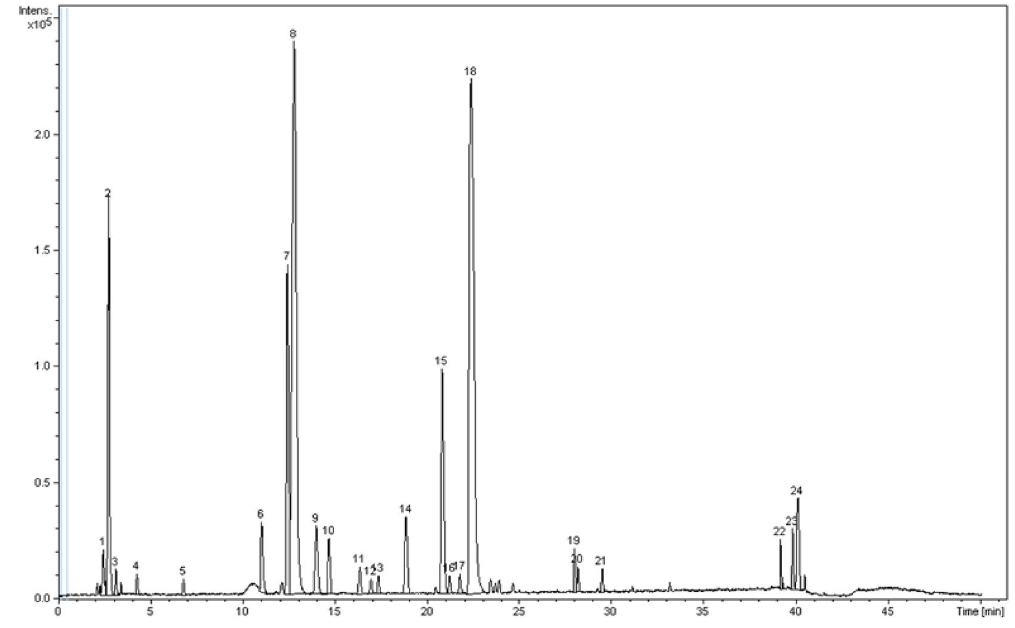
Figure 5. Liquid chromatography-mass spectrometry spectra of phenolic compounds in rambutan peel crude extract obtained from accelerated aqueous ethanol extraction under optimal conditions.